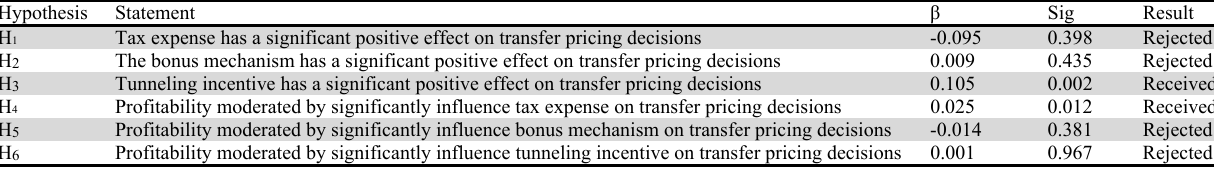
Summary of Hypothesis Test